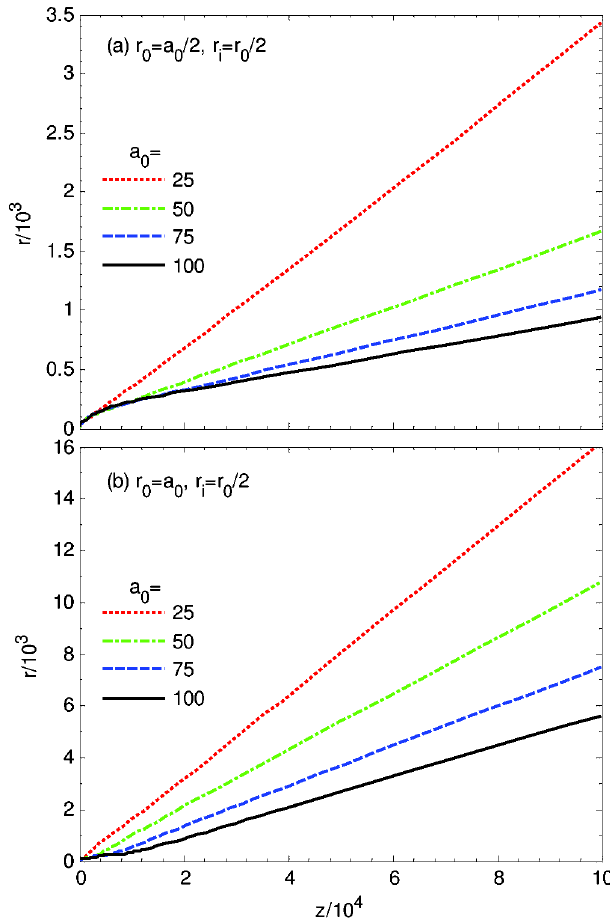
FIG. 3. Electron trajectory for normalized r and z for (a) r 0 ¼ a 0 = 2 and (b) r 0 ¼ a 0 for r i ¼ r 0 = 2 . Dotted, dashed, dot-dashed, and solid lines are for a 0 ¼ 25 , 50, 75, and 100, respectively. The parameters are (cid:3) ¼ 200 , z L ¼ 0 , and t 0 ¼ 0 .